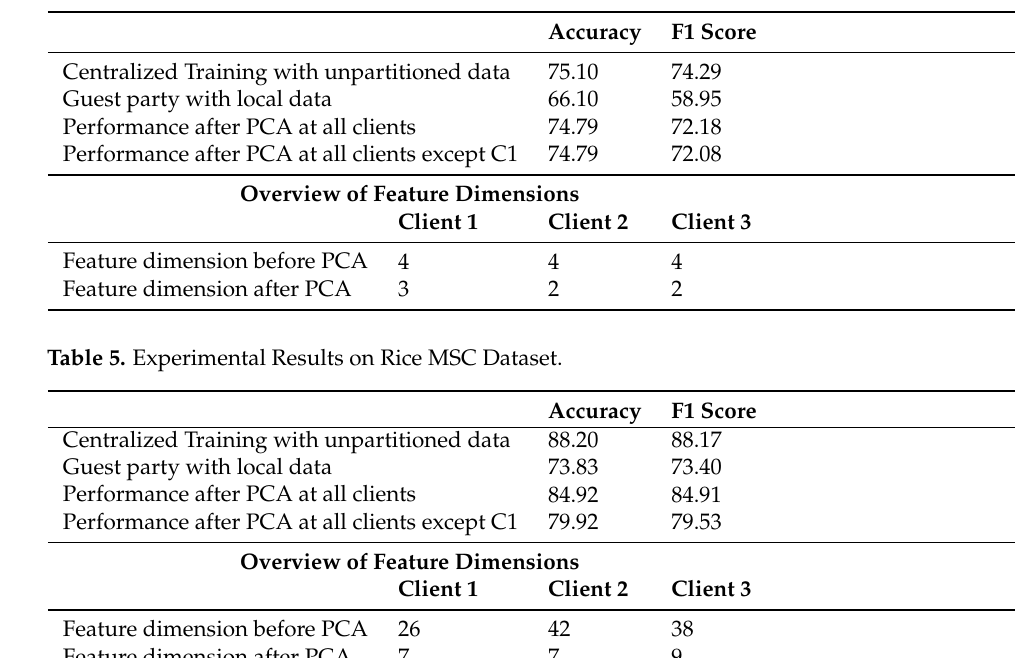
Table 4. Experimental Results on Wine Quality Dataset.